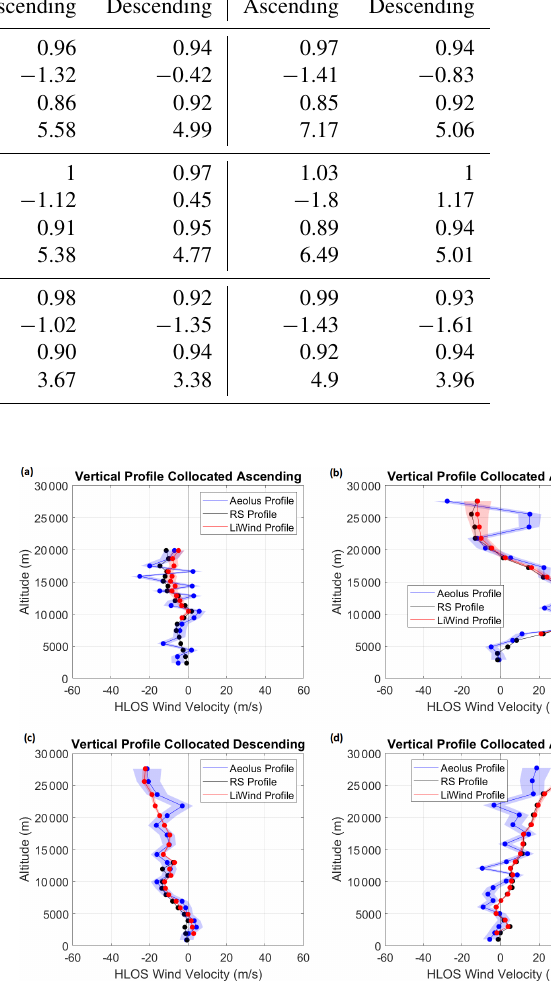
Table 5. Overview of the different comparison method and their relative outcome on the statistical metrics, depending on the instrument and the orbit phase. The data used include all the collocations shown in Tables 1 and 2. RS Lidar Ascending Descending Ascending Descending All data Slope 0.96